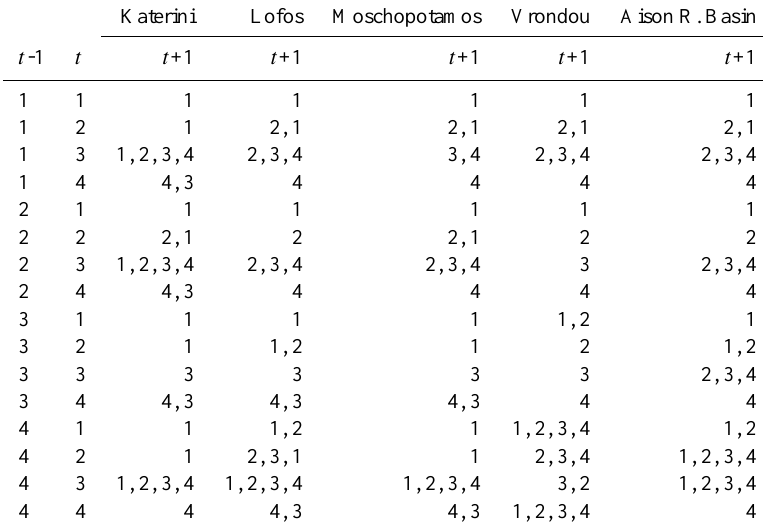
Table 11. Most probable drought class for month t +1, given the drought classes of the two previous months ( t − 1, t ). Katerini Lofos Moschopotamos Vrondou Aison R.